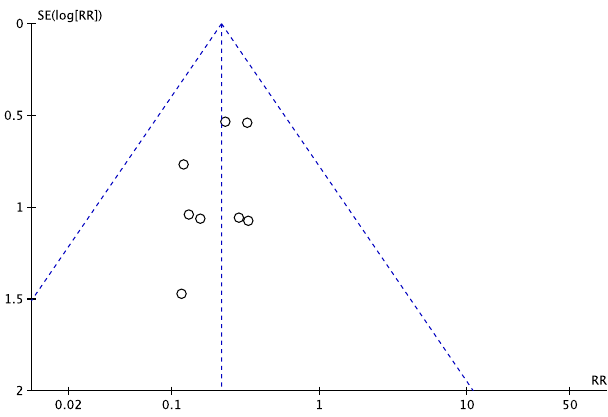
Figure 2. Funnel plot for all studies